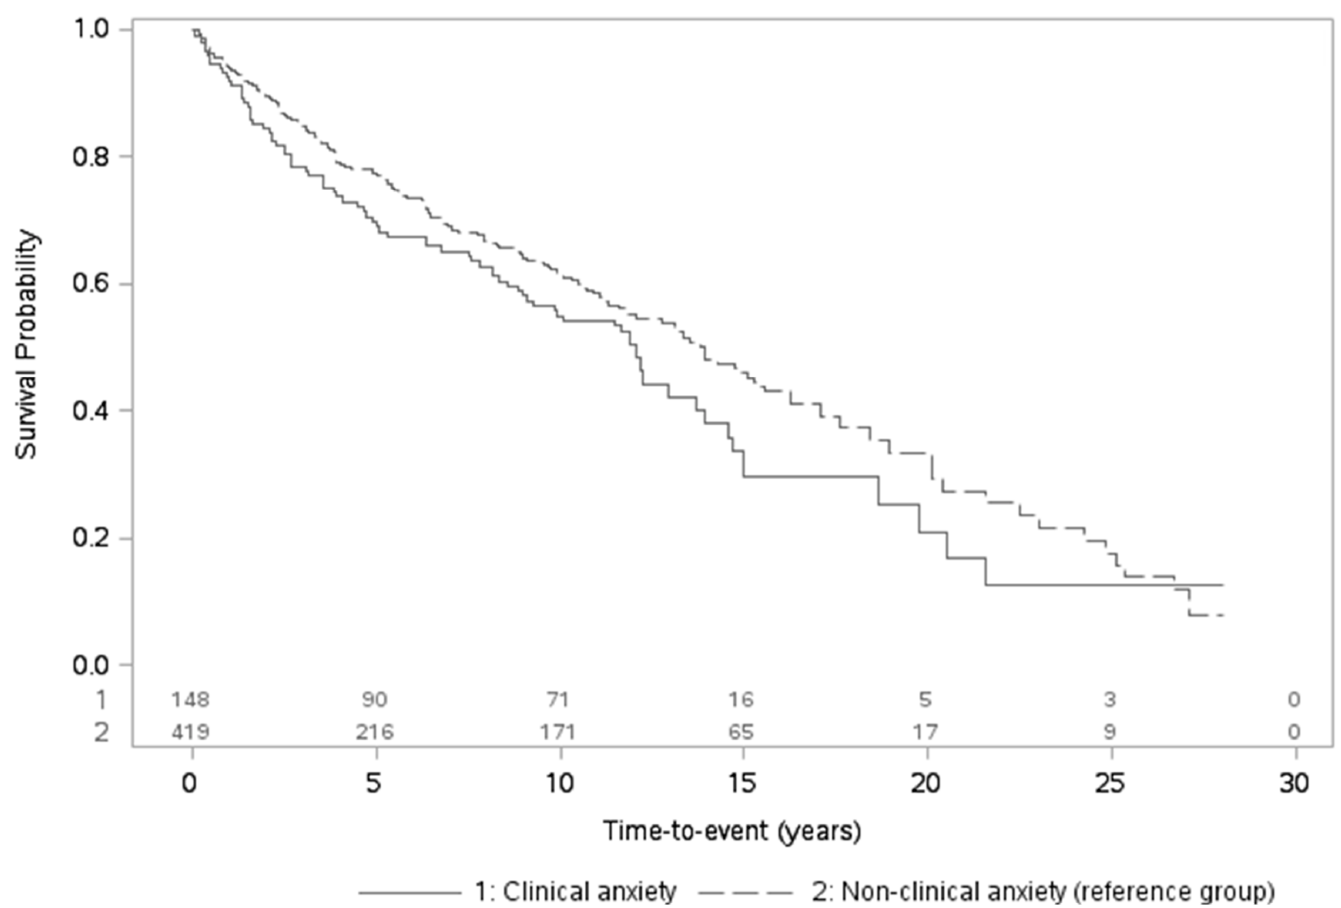
Figure 1. Unadjusted Kaplan-Meier curves for overall mortality in relation to clinical versus non-clinical anxiety levels (including number of participants at risk over time).